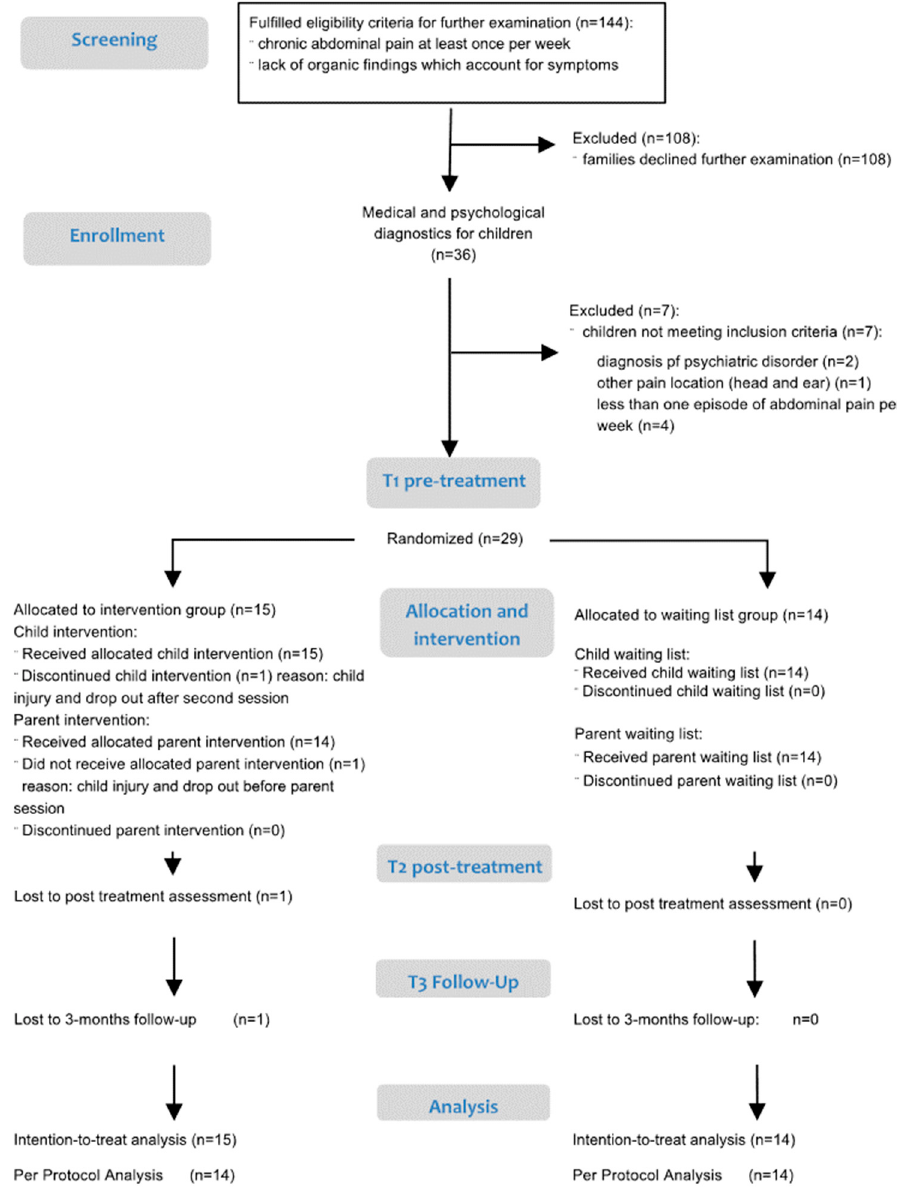
Figure 1. Trial flow chart. Adapted and extended for parent analysis from [31].